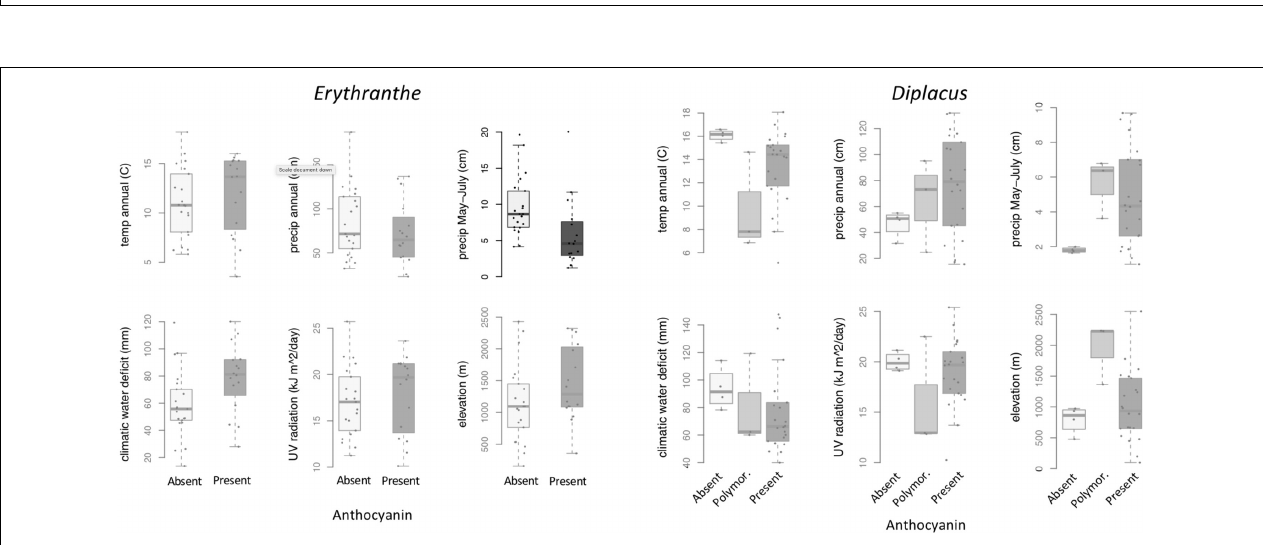
FIGURE 5 | Between-species variation in climate, UV, and elevation affinity by anthocyanin category, displayed as boxplots. Filled circles represent observed data for each anthocyanin category. Opaque plots are those without significant predictors after correcting for multiple tests. See Table 1 for statistical results.